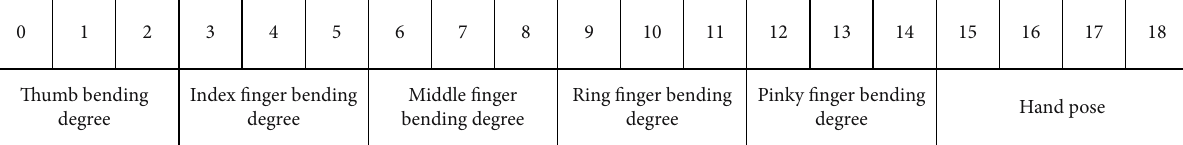
Figure 3: Feature vector embedding mapping.